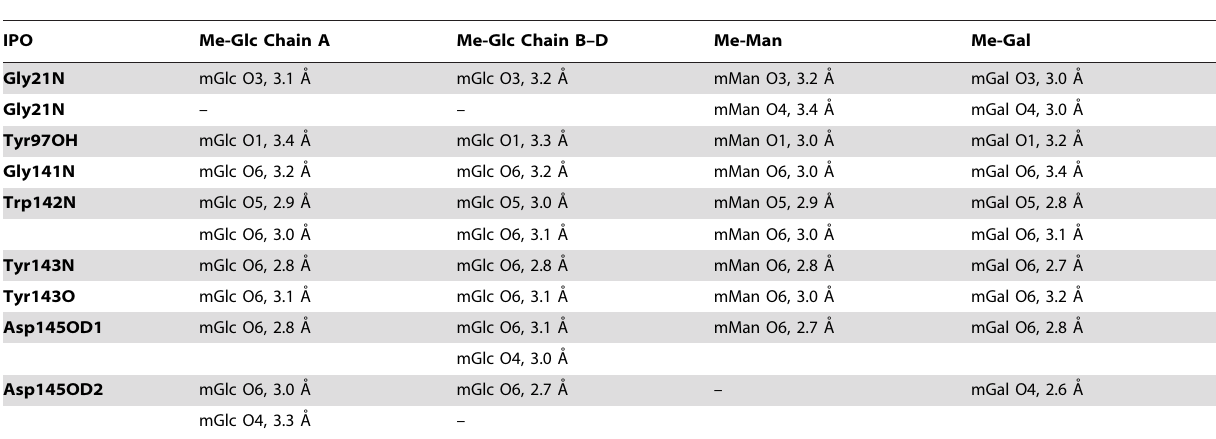
Table 1. Interacting residues of IPO with the carbohydrates Me-Glc, Me-Man, and Me-Gal.